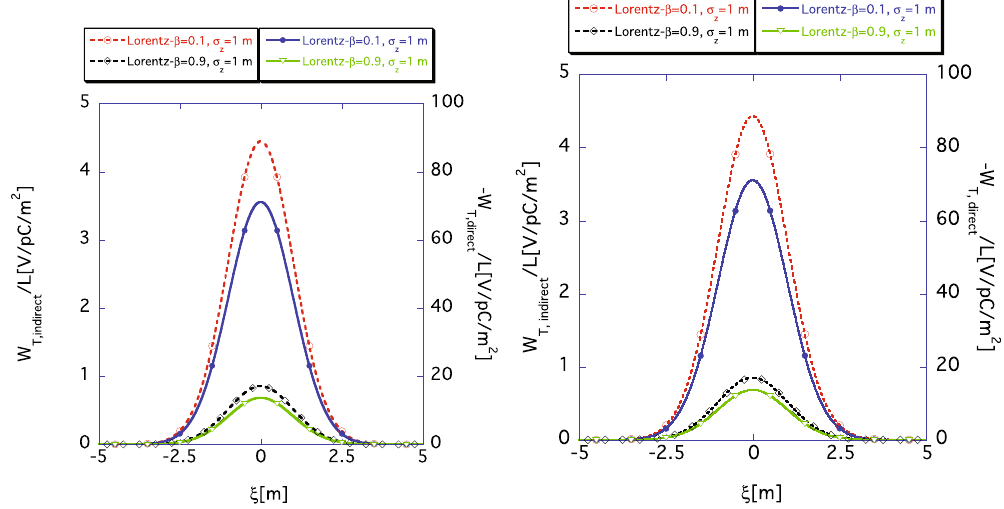
Figure 7. Approximate (left) result obtained using Eqs (77) and (78) and exact (right) one obtained using Eqs (24) and (25) of indirect (dashed) W T , indirect ( ξ ) and direct (solid) W T , direct ( ξ ) wake functions for σ z = 1 m, where r b = 10 mm and a = 40 mm. The dashed ( W T , indirect ( ξ )) and the solid ( W T , direct ( ξ )) lines are read using the scale markings on the left and the right vertical axes, respectively. The purple and red lines show the wake functions for β = 0.1 m and the green and black lines for β = 0.9 m,